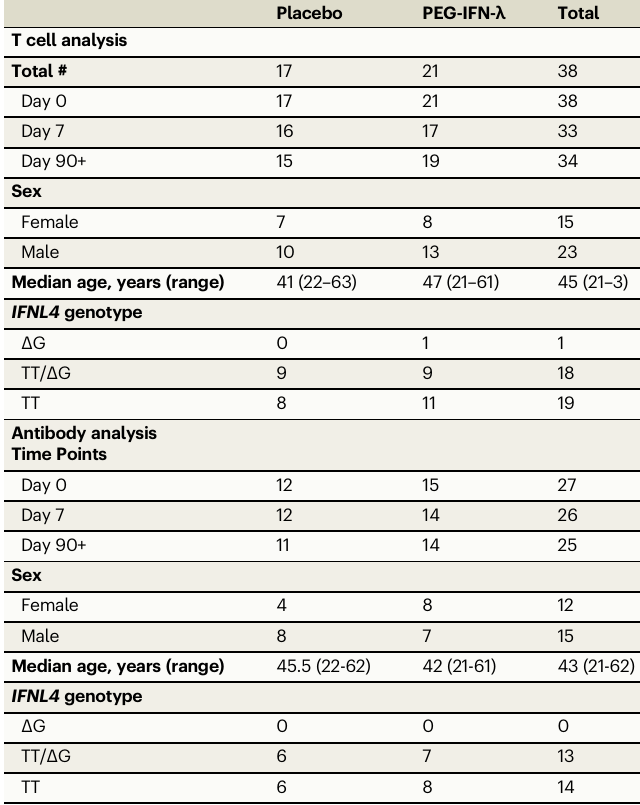
Table 1 | Patient characteristics for T cell and antibody analyses